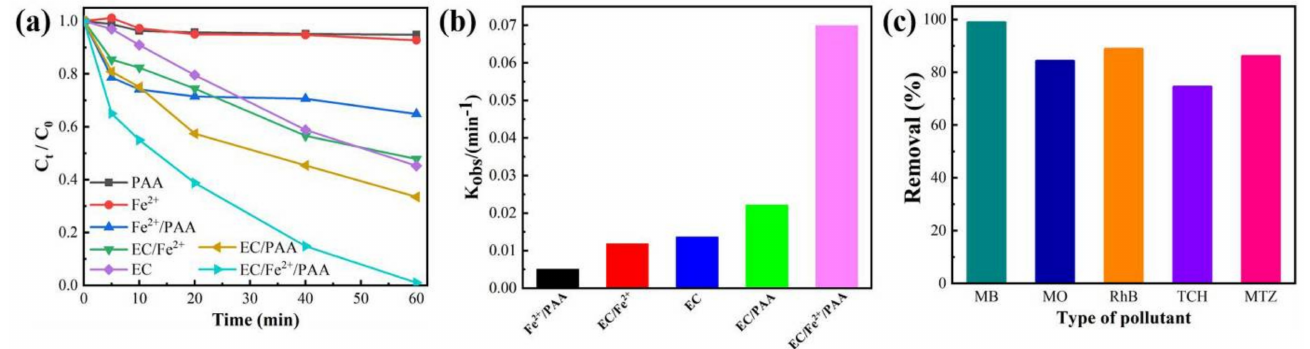
Figure 1. Decolorization ratio ( a ) and reaction rate constant ( b ) of MB in various systems. ( c ) Di- verse organic pollutant removal in EC/Fe 2+ /PAA system. Experimental conditions: [MB] 0 = [MO] 0 = [RhB] 0 = [TCH] 0 = [MTZ] 0 = 20 mg L − 1 , [Fe 2+ ] 0 = 30 µ mol L − 1 , [PAA] 0 = 5.4 mmol L − 1 , [H 2 O 2 ] 0 = 11.25 mmol L − 1 , [NaNO 3 ] = 30 mmol L − 1 , pH = 2.9, j = 15 mA cm − 2